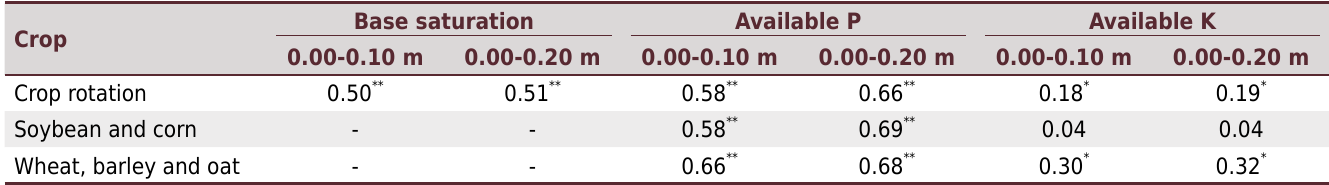
Table 5. Correlation between relative grain yield and fertility attributes of soil layers under long-term no-tillage management